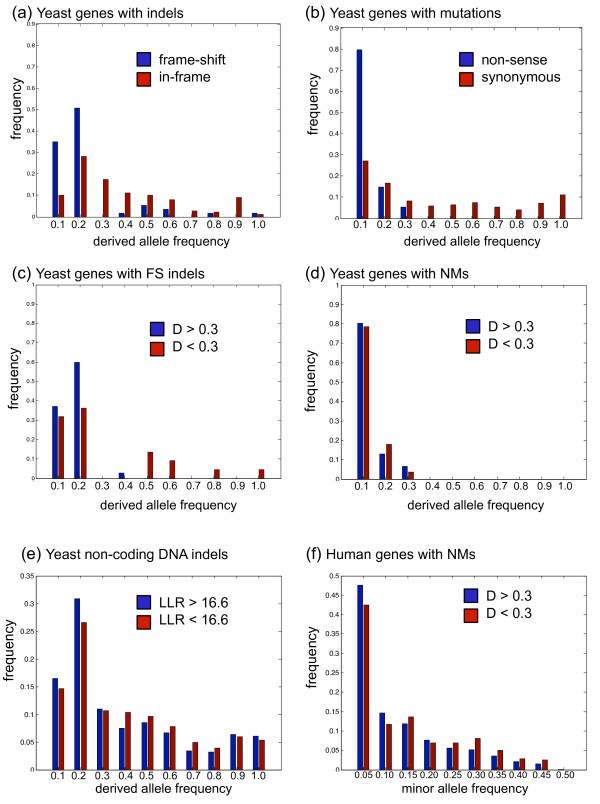
Spectrums of mutation allele frequencies. (a) Distribution of yeast frame-shifting indels (blue) skewed to lower DAFs compared to genes with in-frame indels (red) suggesting a relatively greater selective pressure on these genes. (b) Distribution of yeast NMs (blue) skewed towards the lower DAFs compared to the genes with synonymous SNPs (red) suggesting a relatively greater selective pressure. (c) Distributions of yeast FS indels that cause (blue) larger information loss (D > 0.3) and the those that cause (red) lower loss (D < 0.3). (d) In the case of genes with NMs, no mutations with higher allele frequency were observed and therefore the results are inconclusive. (e) Distribution of yeast non-coding DNA sites harbouring indels versus the indels' derived allele frequency (DAF) for two classes of indels: (blue) indels that fall in highly conserved sites (LLR > 16.6) and (red) indels that fall in less conserved sites (LLR < 16.6). The threshold THR = 16.6 is obtained using the Poisson random fields method (see Methods). (f) Distribution of human NMs versus their minor allele frequency in the human population for two classes of mutations causing (blue) greater information loss (D > 0.3) and (red) less information loss (D < 0.3), respectively.